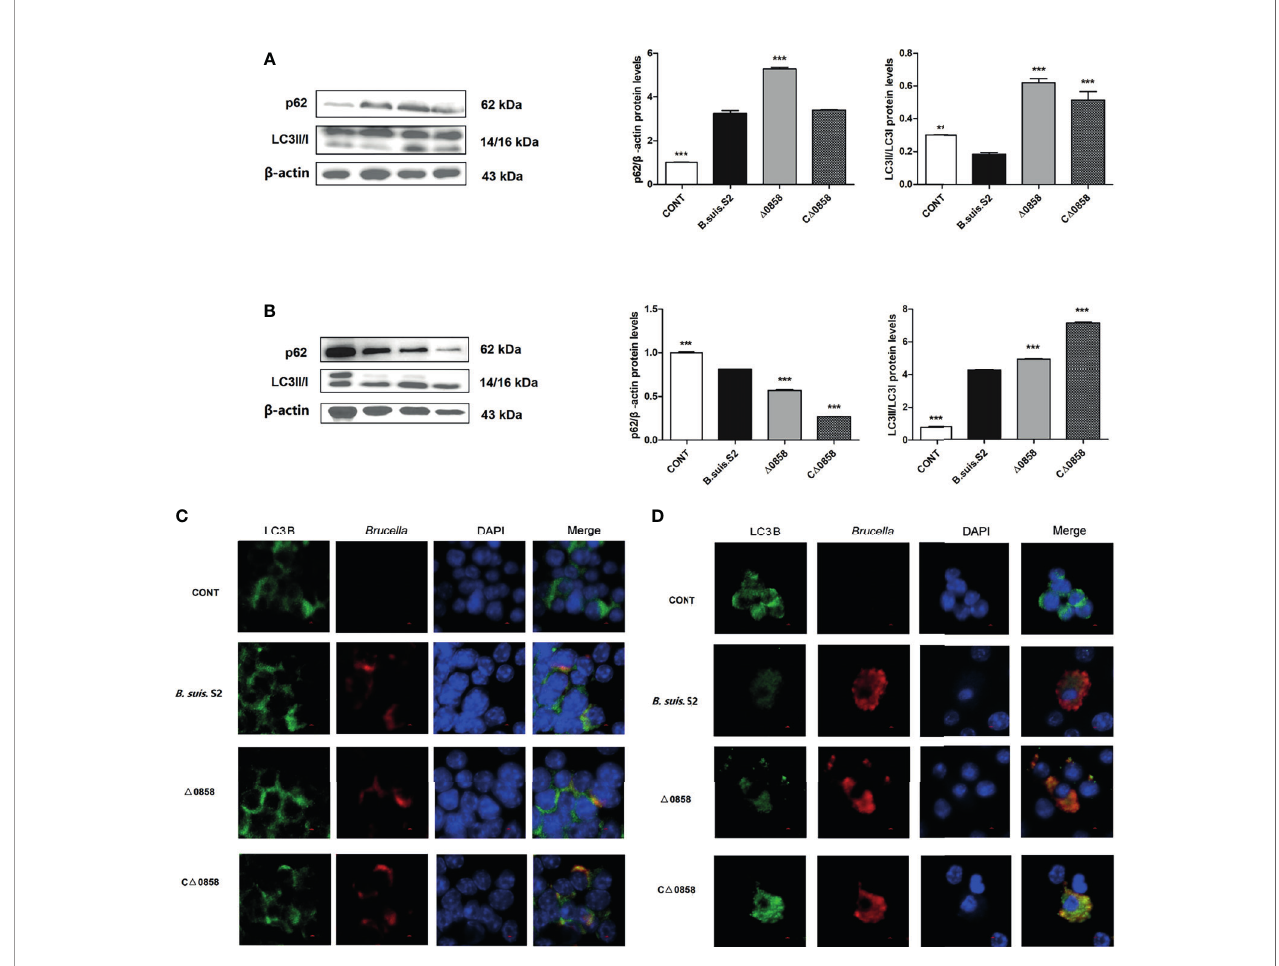
FIGURE 3 | BSS2_II0858 mutant induced the occurrence of autophagy. (A) Light chain 3II (LC3II) and p62 proteins level in WT, BSS2_II0858 mutant, and complementation strain-infected RAW 264.7 at 24 h. (B) LC3II and p62 proteins level in WT, BSS2_II0858 mutant, and complementation strain-infected RAW 264.7 at 48 h. Data represent the mean ± standard deviations from 3 independent experiments: ** p < 0.01, *** p < 0.001. (C, D) Formation of LC3 puncta (green) and intercellular Brucella (red) was observed under the confocal microscope after Brucella infection at 24 (C) and 48 h (D) . Scale bars: 2